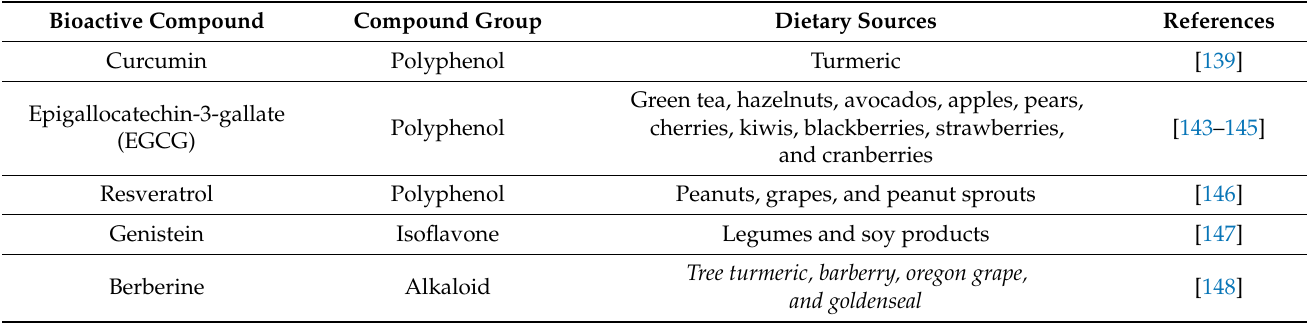
Table 1. Classification and major dietary sources of anti-inflammatory bioactive compounds that have the potential to treat microvascular complications of